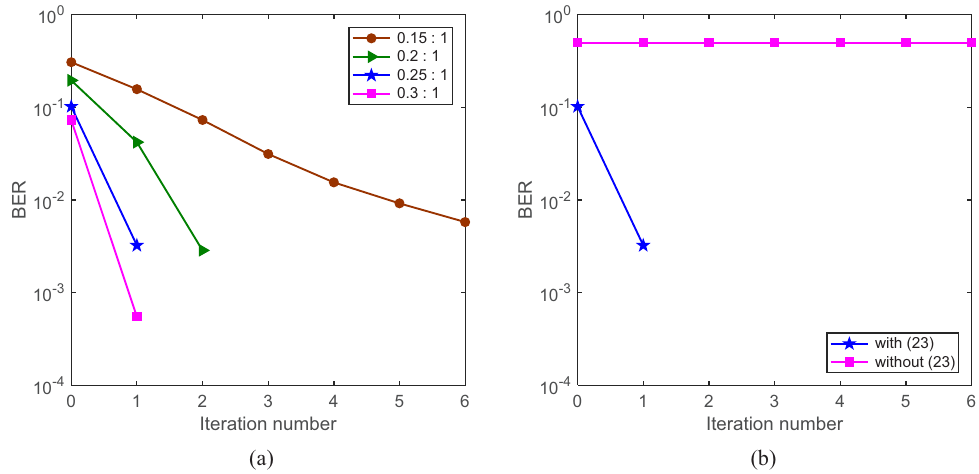
Figure 9. BER performance of the system with S128 and SNR = 13 dB. ( a ) A variety of power ratios of the training sequence and the symbol sequence; ( b ) with or without the training interference elimination. The power ratio is